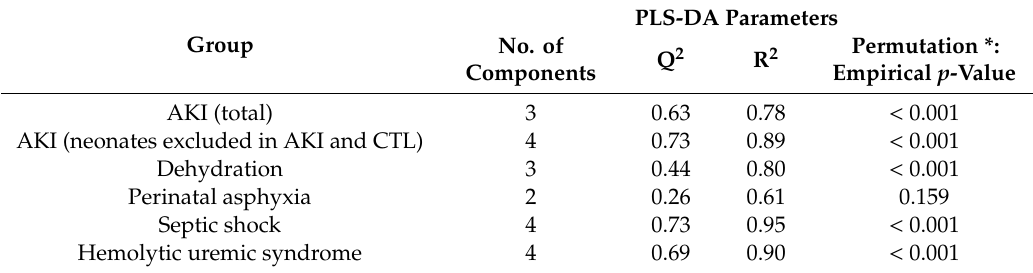
Table 2. Explained variance and predictability for AKI and subgroups when compared to the combined control group (non-AKI patients plus healthy control subjects). PLS-DA Parameters Group No. of Permutation Components